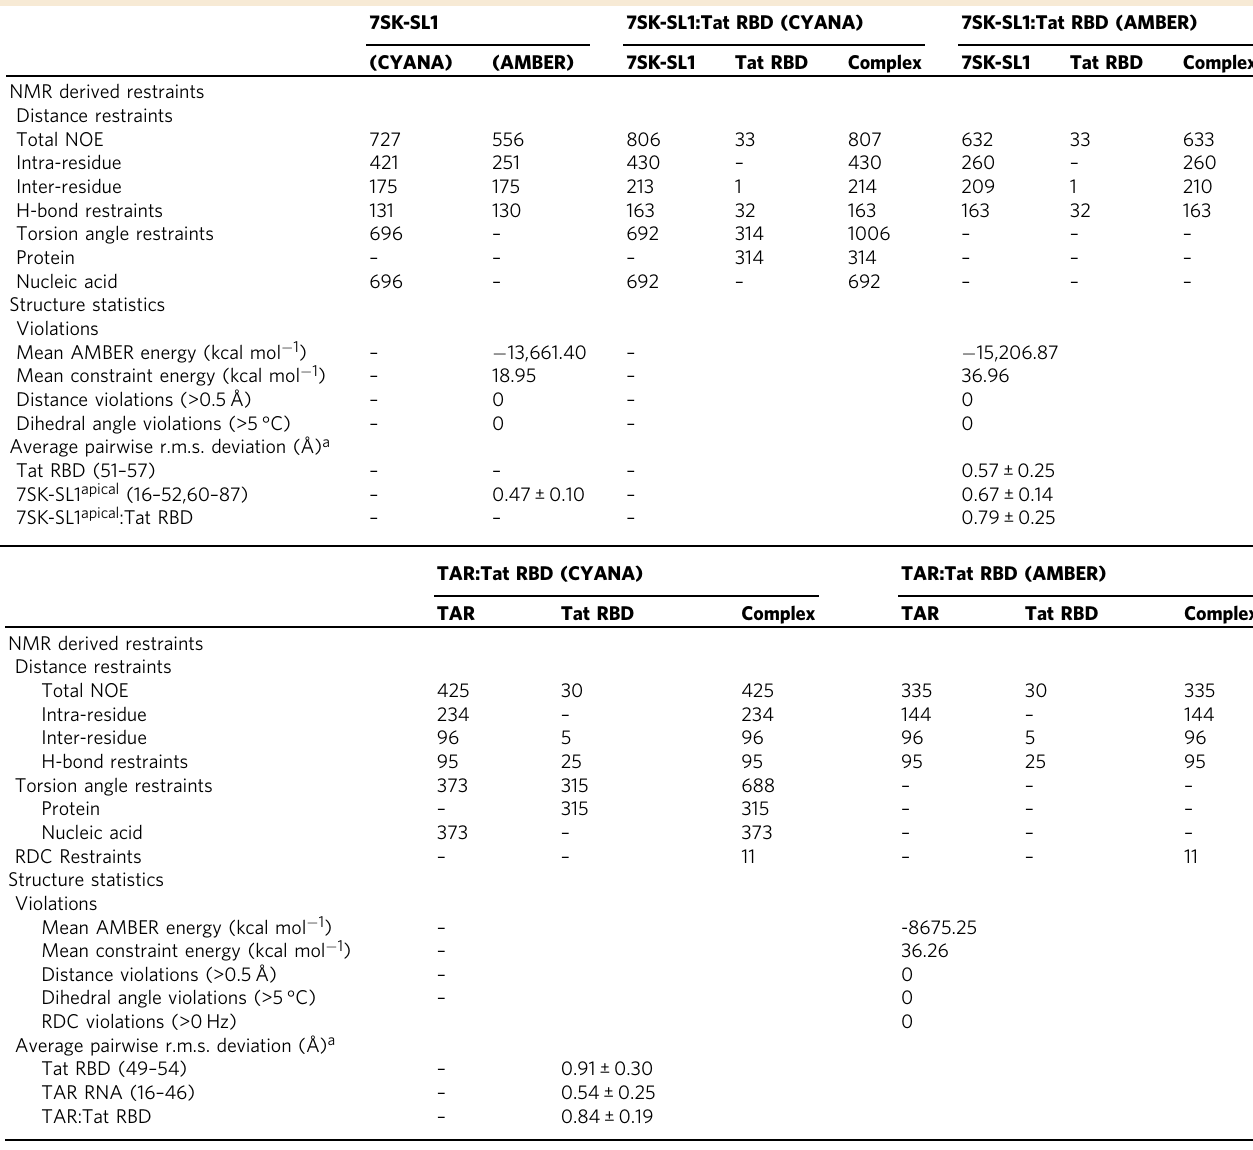
Table 1 NMR statistics and restraints for 7SK-SL1 apical , 7SK-SL1 apical :Tat RBD, and Tat